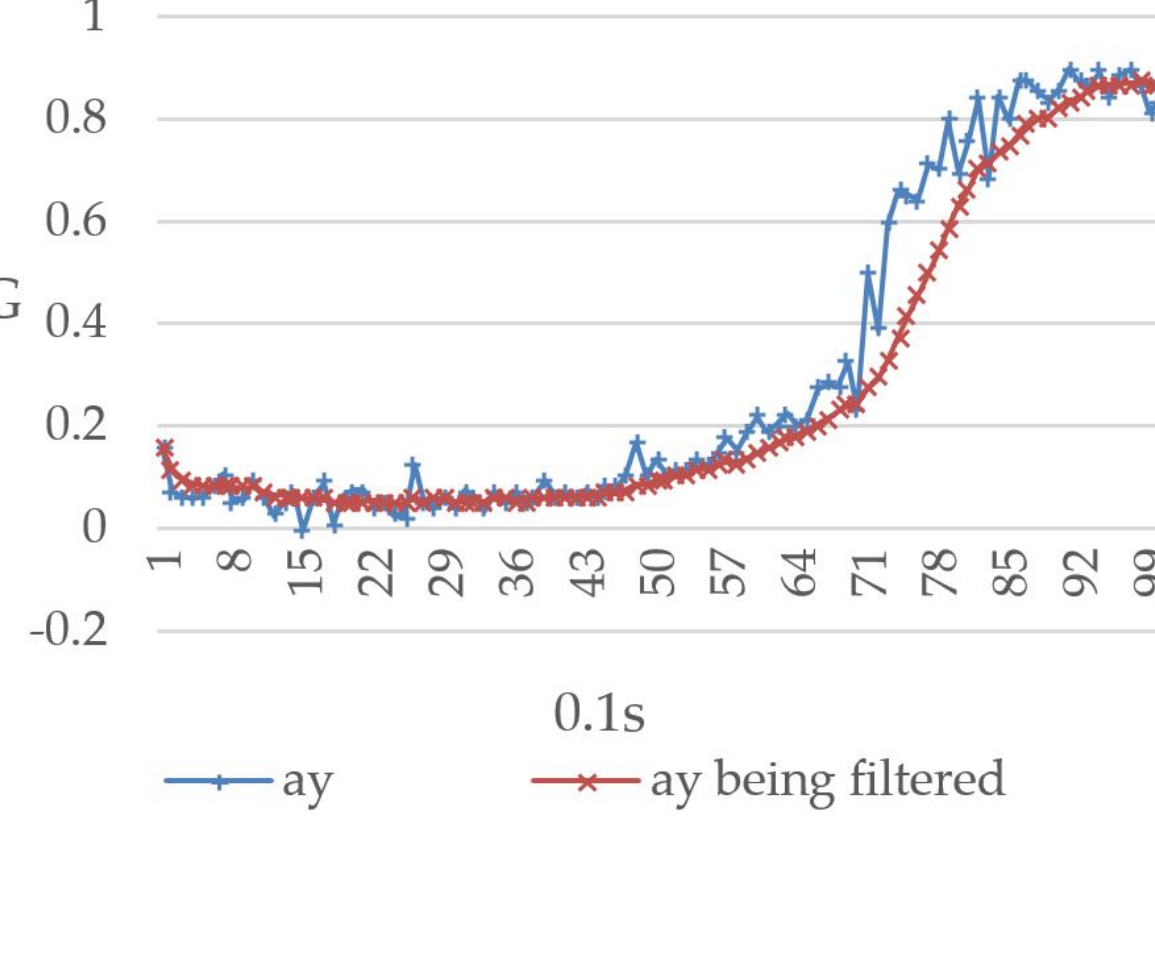
Figure 13. Triple axis accelerometer's pre-filtered y -axis values (ay) and filtered y -axis values (ay being filtered) when the user's body was tilted